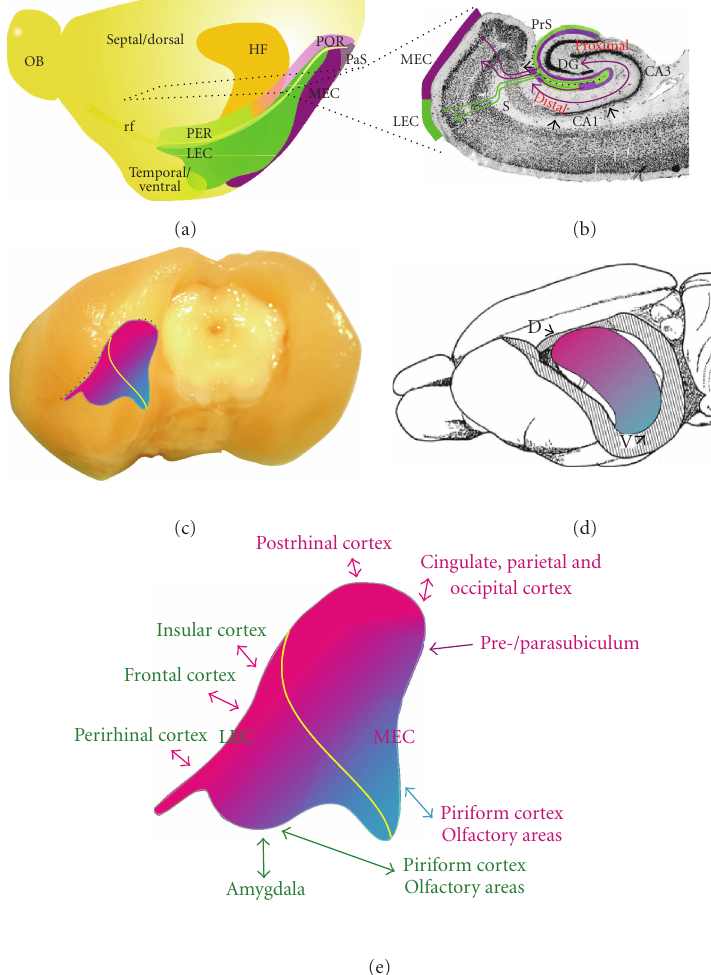
Figure 1: Schematic representation of the overall organization of the entorhinal cortex and its connectivity. (a) Position of the entorhinal cortex and surrounding cortices and hippocampus in the rat left hemisphere. Indicated are the dorsoventral extent of the hippocampus, positions of LEC and MEC, and the approximate position of a representative horizontal section, illustrated in (b). (b) Horizontal section illustrating entorhinal-hippocampal connectivity (see text for more details). (c) and (d) Representation of the topographical arrangement of entorhinal-hippocampal reciprocal connections. A dorsolateral band of entorhinal cortex (magenta) is preferentially connected to the dorsal hippocampus. Increasingly, more ventral and medial bands of entorhinal cortex (purple to blue) are connected to increasingly more ventral levels of the hippocampus. Yellow line in (c) indicates the border between LEC and MEC. (e) Enlarged entorhinal cortex, taken from (c), indicating the main connectivity of di ff erent portions of entorhinal cortex. Brain areas preferentially connected to LEC are printed in green, those connected to MEC are in magenta. The color of the arrows indicates preferential connectivity to the dorsolateral-toventromedial bands of entorhinal cortex (magenta or blue, resp.) or that no preferential gradient is present